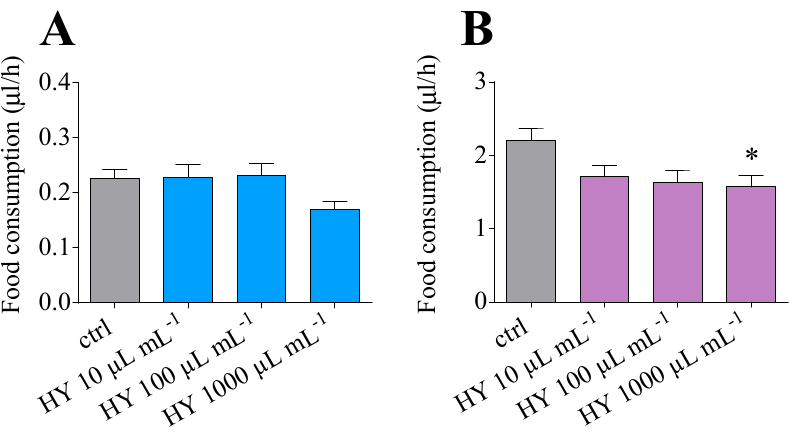
Figure 4. Food intake in D. suzukii adults after 48 h feeding on diet treated with M. didyma HY LC 50 . ( A ) Food consumption, measured as µ L of diet per hour, of D. suzukii males. ( B ) D. suzukii females. Data shown are the means ± SEM of four independent biological replicates. * p < 0.05 vs. control according to one-way ANOVA followed by Dunnett’s test for multiple comparisons.